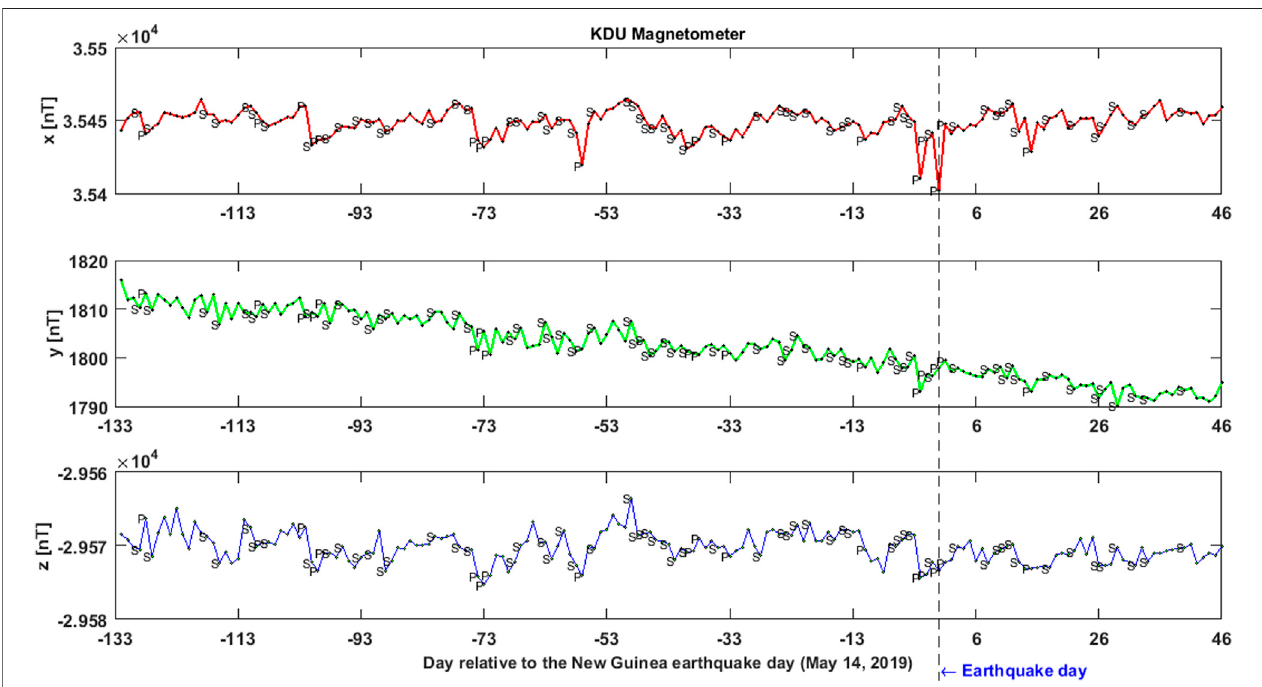
FIGURE3| KDUmagnetometer(12.69 ° S,132.47 ° E)measurements (A) x, (B) y,and (C) zduringtheperiodfromJanuary01toJune30,2019.Theearthquakeday is indicated by a dashed black vertical line.